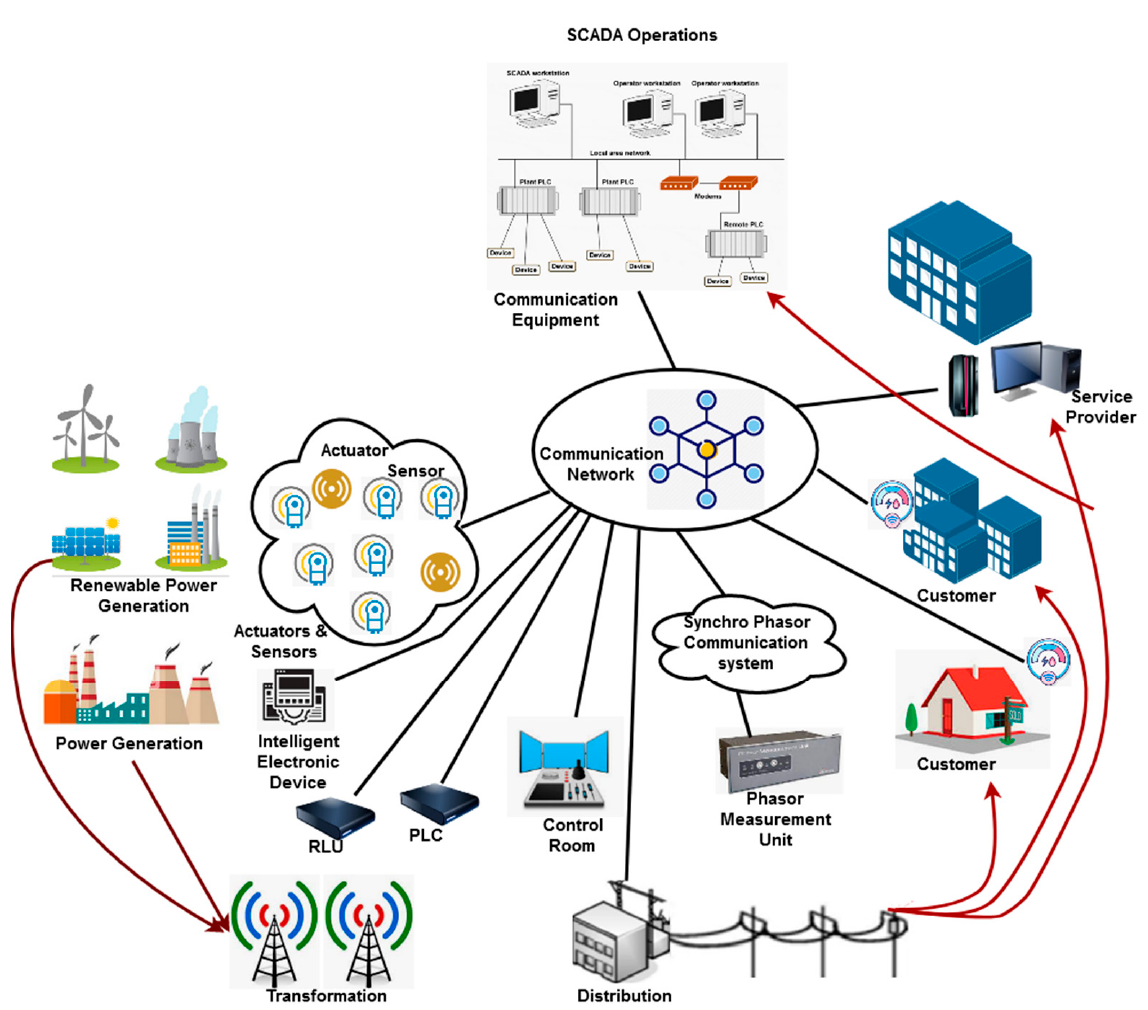
Figure 2. Architecture model of the smart grid network with cyber layer elements.